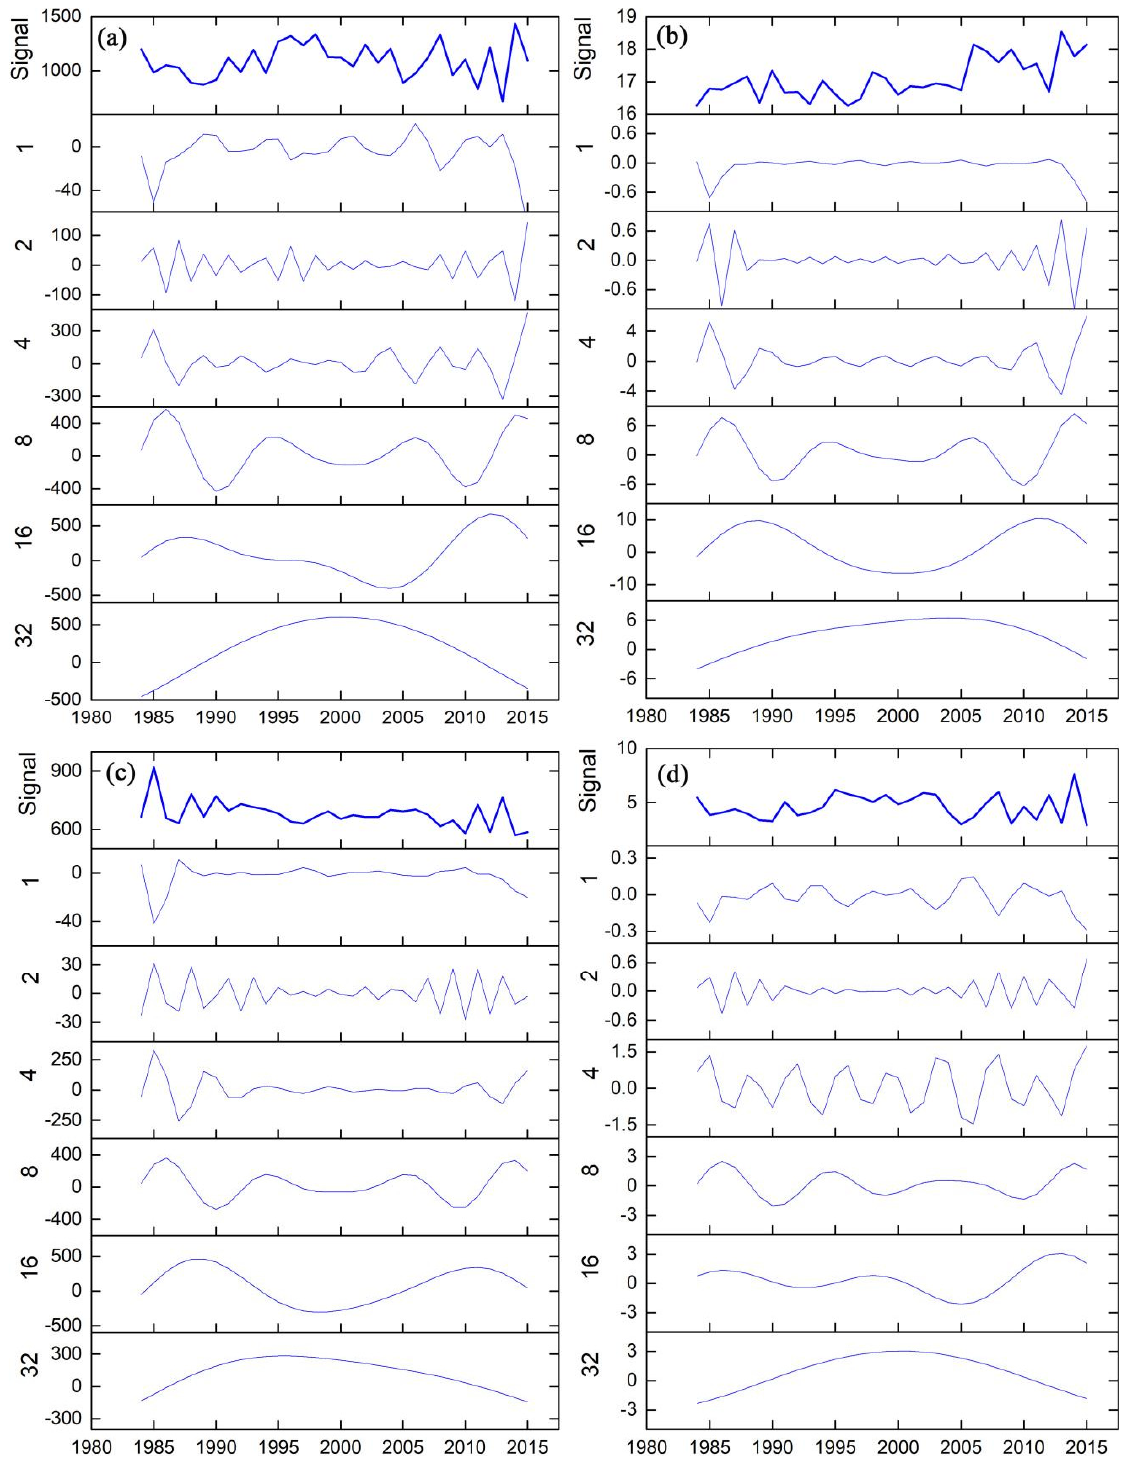
Figure 8. Multi-time-scale variations of annual rainfall ( a ), temperature ( b ), evaporation ( c ) and runoff ( d ).